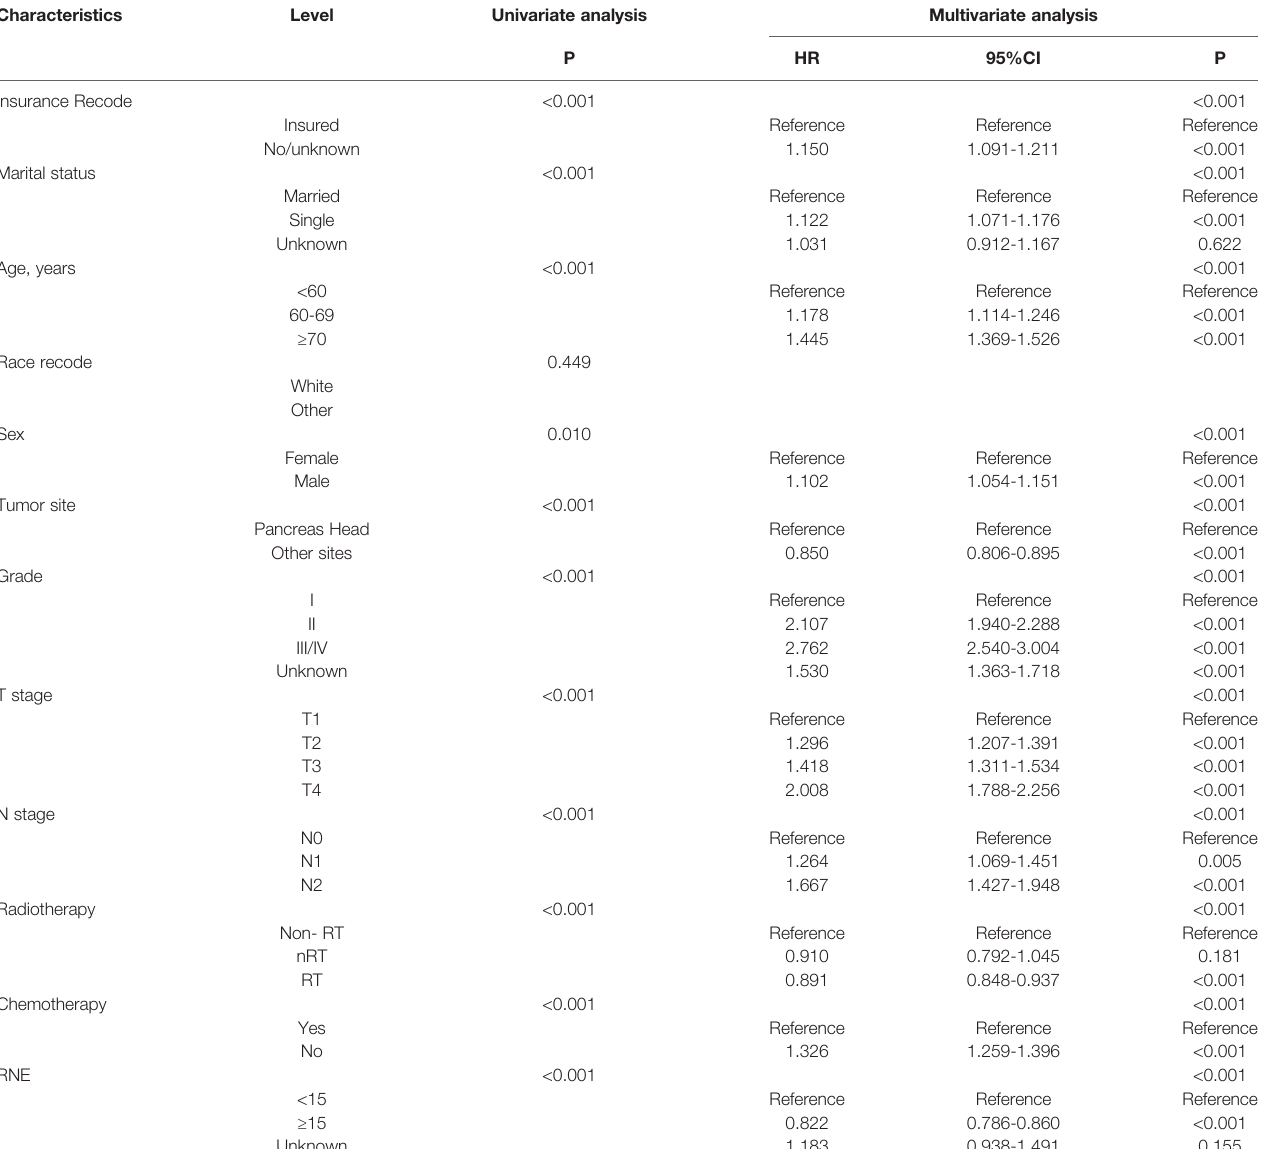
TABLE 2 | Univariate and multivariate analysis for OS of all stage IIB/III PDAC patients.